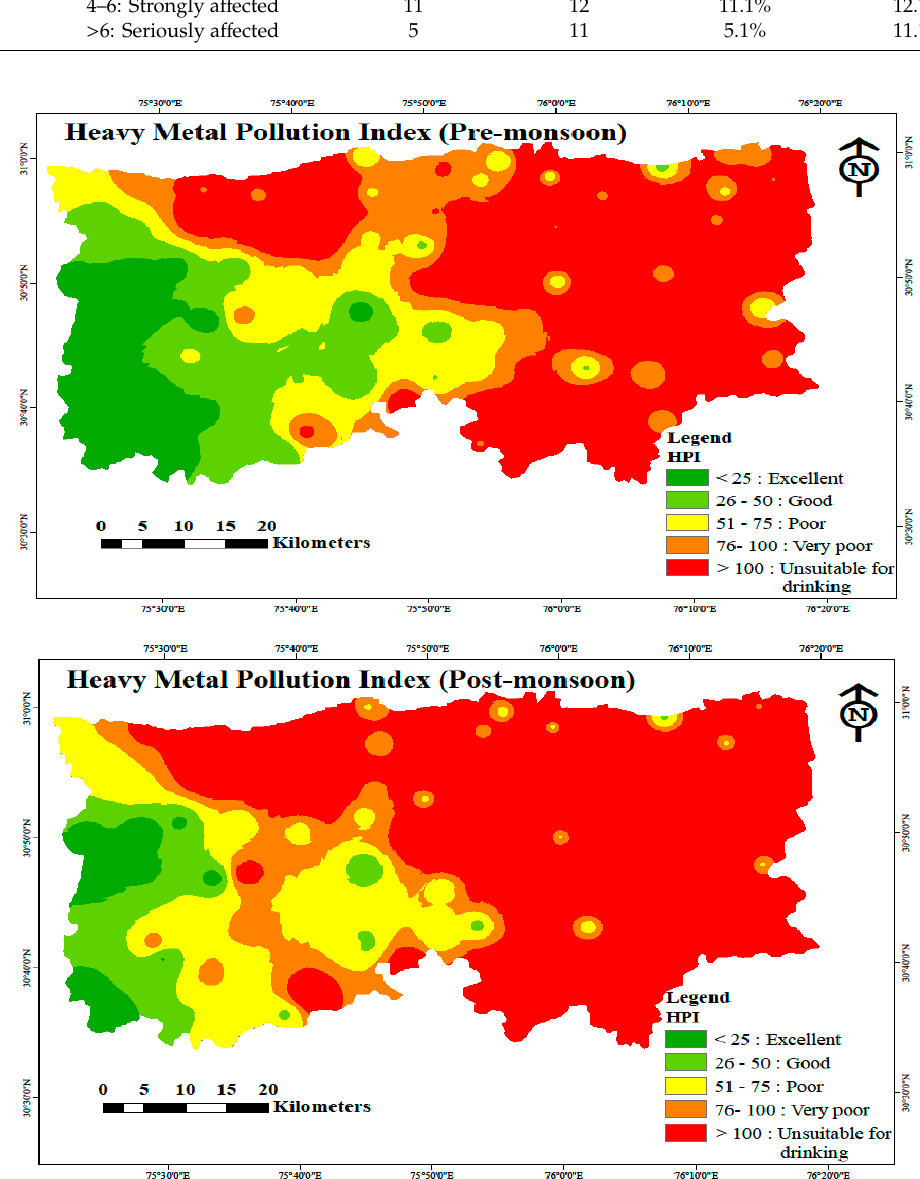
Figure 3. Geospatial variation of the HPI during pre- and postmonsoon